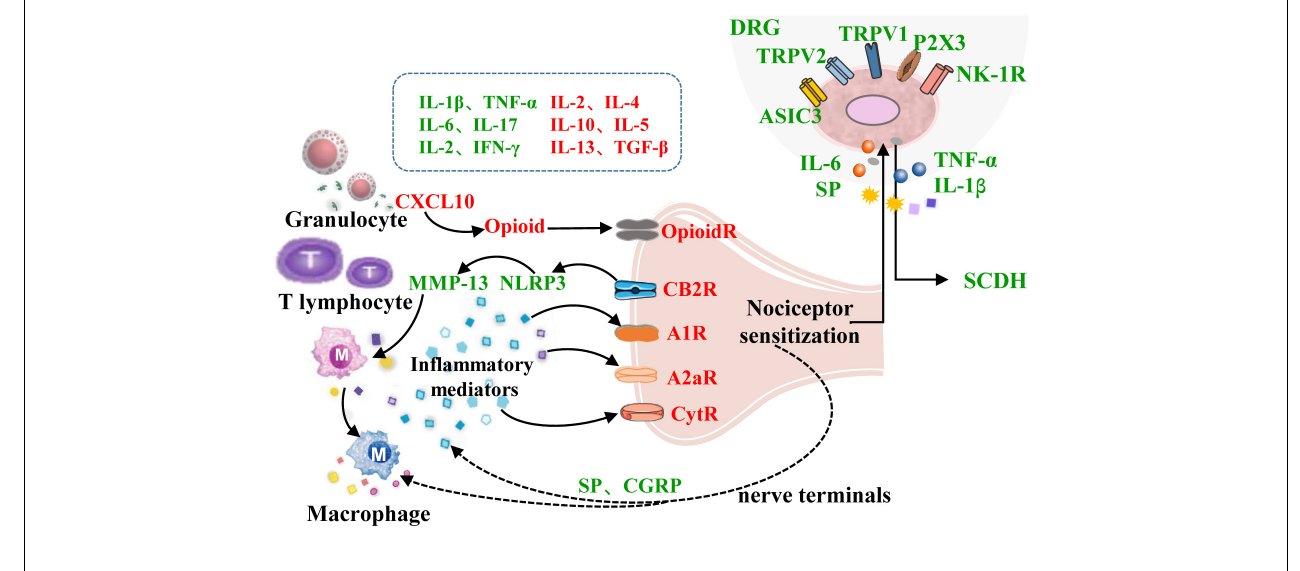
FIGURE 3 | Role of neuroimmune crosstalk at the sites of inflammation in mediating the anti-inflammatory and analgesic effects of acupuncture on inflammatory pain. The names of immune factors are presented in red and green, respectively. The factors in red are up-regulated by acupuncture, while those in green are down-regulated by acupuncture. IL-1 β /2/4/5/6/10/13/17, interleukin-1 β /2/4/5/6/10/13/17; IFN- γ , interferon- γ ; TGF- β , transforming growth factor; CXCL10, chemokine (C-X-C motif) ligand 10; NLRP3, NOD-like receptor family 3; MMP13, matrix metalloproteinase-13; A1R, adenosine 1 receptor; CytR, cytokine receptor; OpioidR, opioid receptor; A2aR, adenosine 2a receptor; SP, substance P; CB2R, cannabinoid receptor 2; P2 × 3, Purinergic P2 × 3 receptor; NK-1R, neurokinin-1 receptor; ASIC3, acid sensation ion channels 3; CGRP, calcitonin-gene-related peptide; TRPV1/2, transient receptor potential ion channel vanilloid 1/2; DRG, dorsal root ganglion; SCDH, spinal cord dorsal